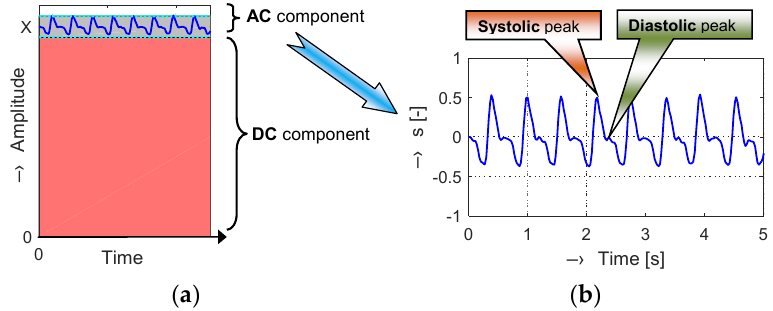
Figure 1. Principal structure of a photoplethysmographic (PPG) signal: ( a ) alternating current (AC) and direct current (DC) components superposition; ( b ) PPG volume pulse wave after signal processing (pre-filtering and DC component